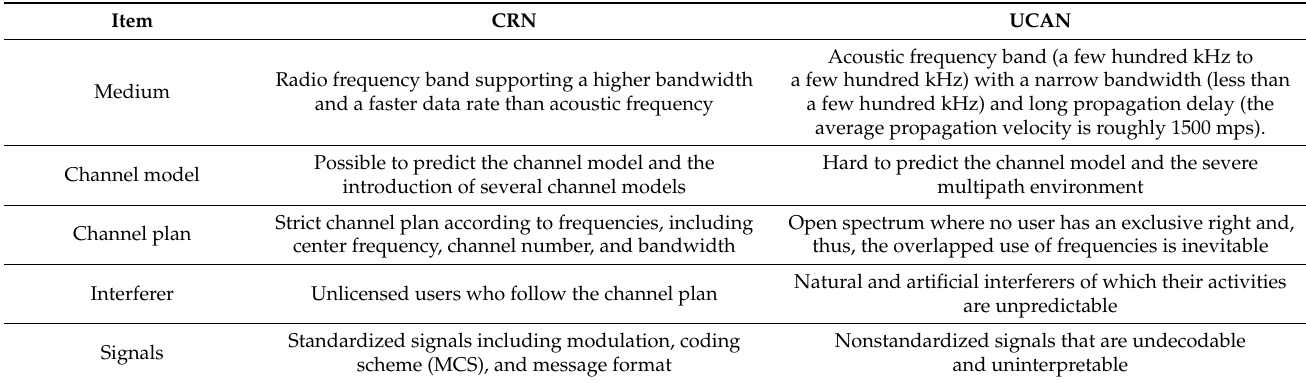
Table 1. The gap between a UCAN and a